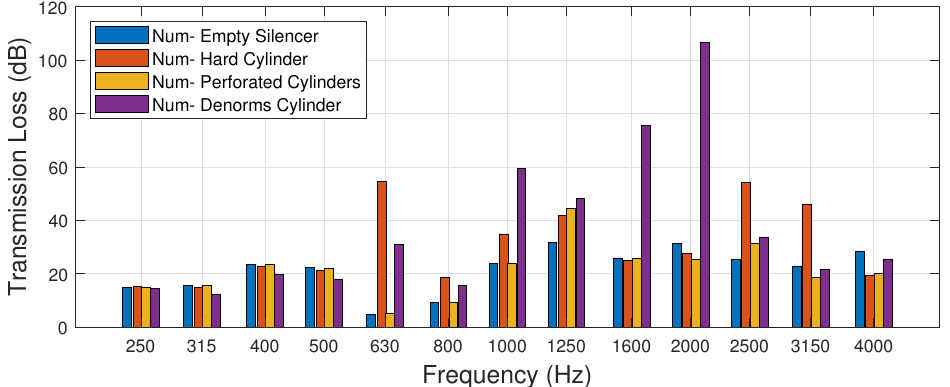
Figure 15. Numerical cylinder type performance comparison as a function of third octave band.